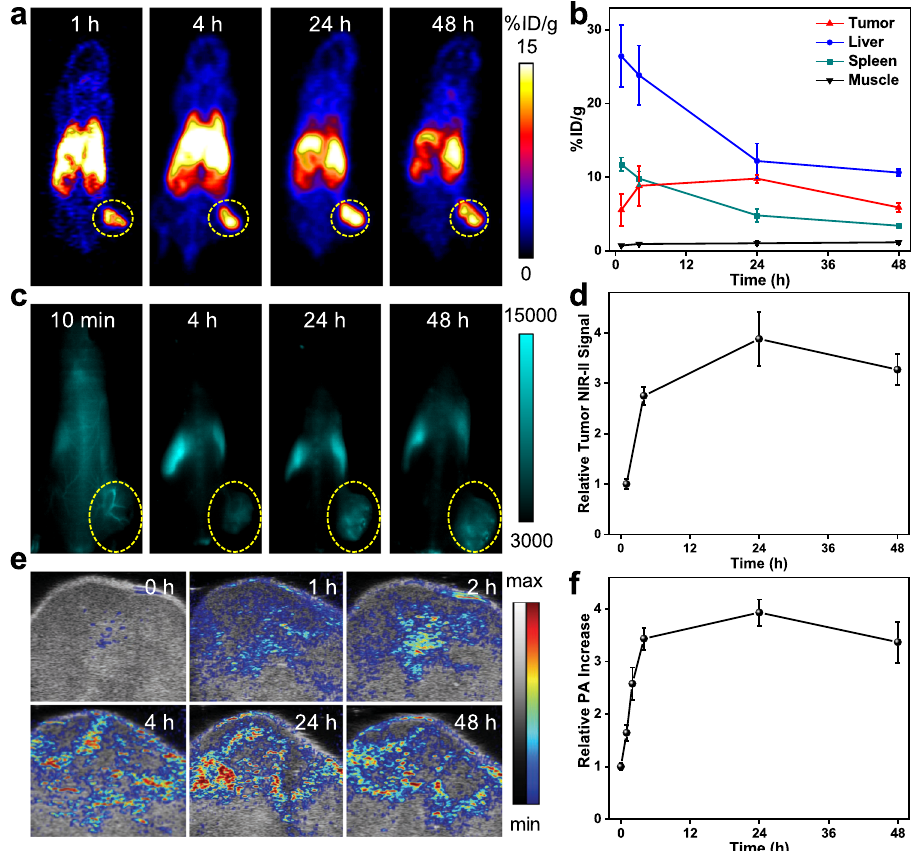
Fig. 6 In vivo multi-modal imaging. U87MG tumor-bearing mice were intravenously injected with 64 Cu-labeled pHPFON-NO/O 2 for PET imaging or non- labeled pHPFON-NO/O 2 for NIR-II fl uorescence and PA imaging. a Representative PET images at 1, 4, 24, 48 h p.i. Tumors are circled with yellow dots. b PET quanti fi cation on tumors and selected organs according to a . c Representative NIR-II images at selected time points. Tumors are circled with yellow dots. d Relative NIR-II signals at the tumor regions. e Representative tumoral PA images. f Relative PA signal changes. n = 3 biologically independent animals. Data are presented as mean ±